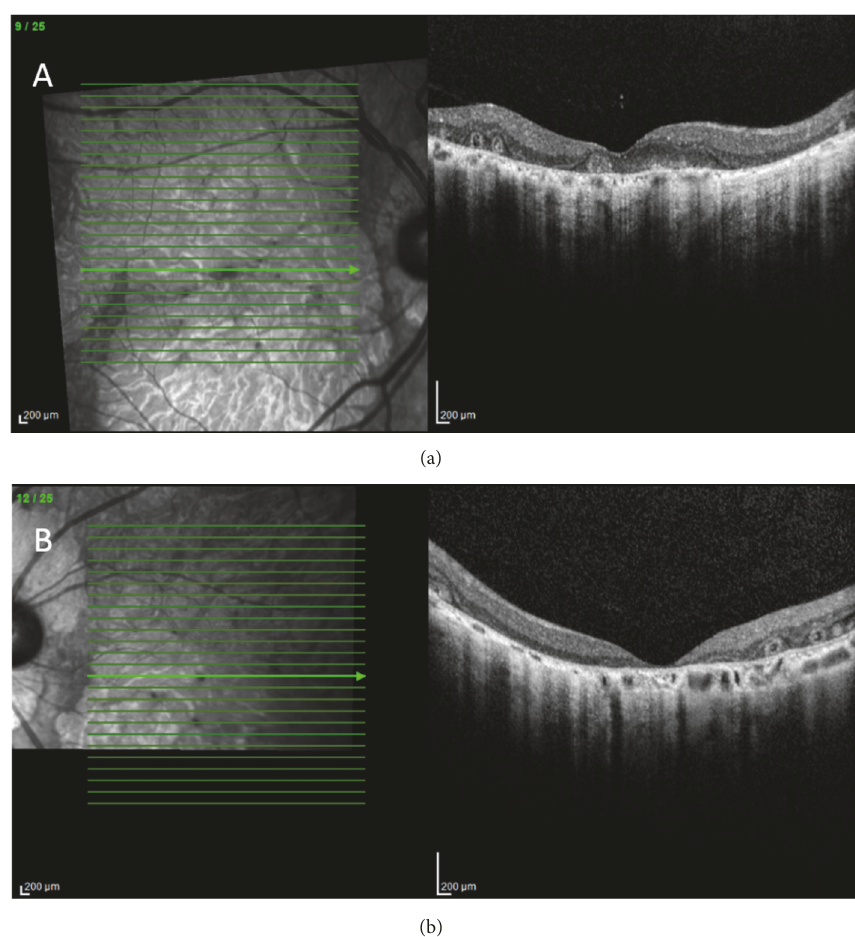
Figure 2: (a) and (b) SDOCT shows outer retinal and choriocapillaris atrophy with outer retinal tubulations OU.